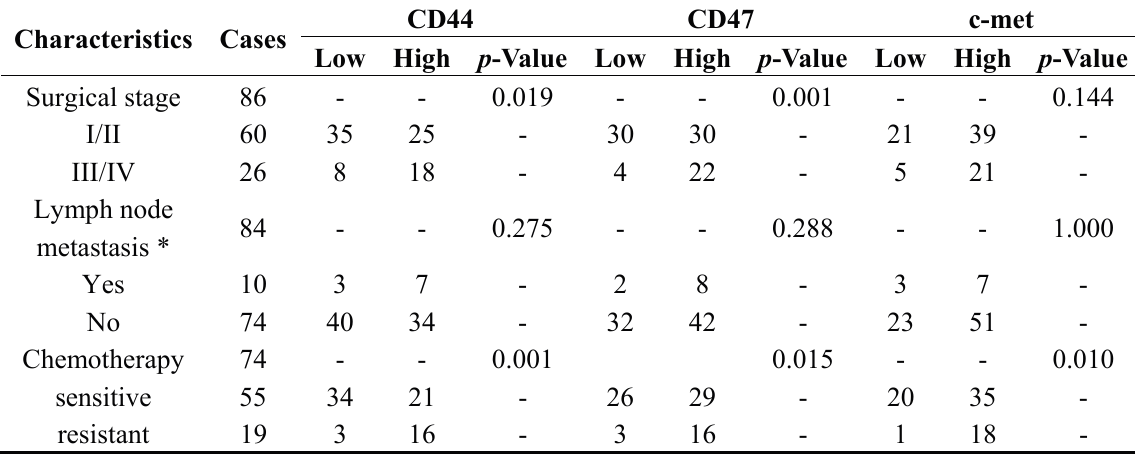
Table 2. Relationship between CD44, CD47 and c-met levels and clinicopathological features of OCCC.